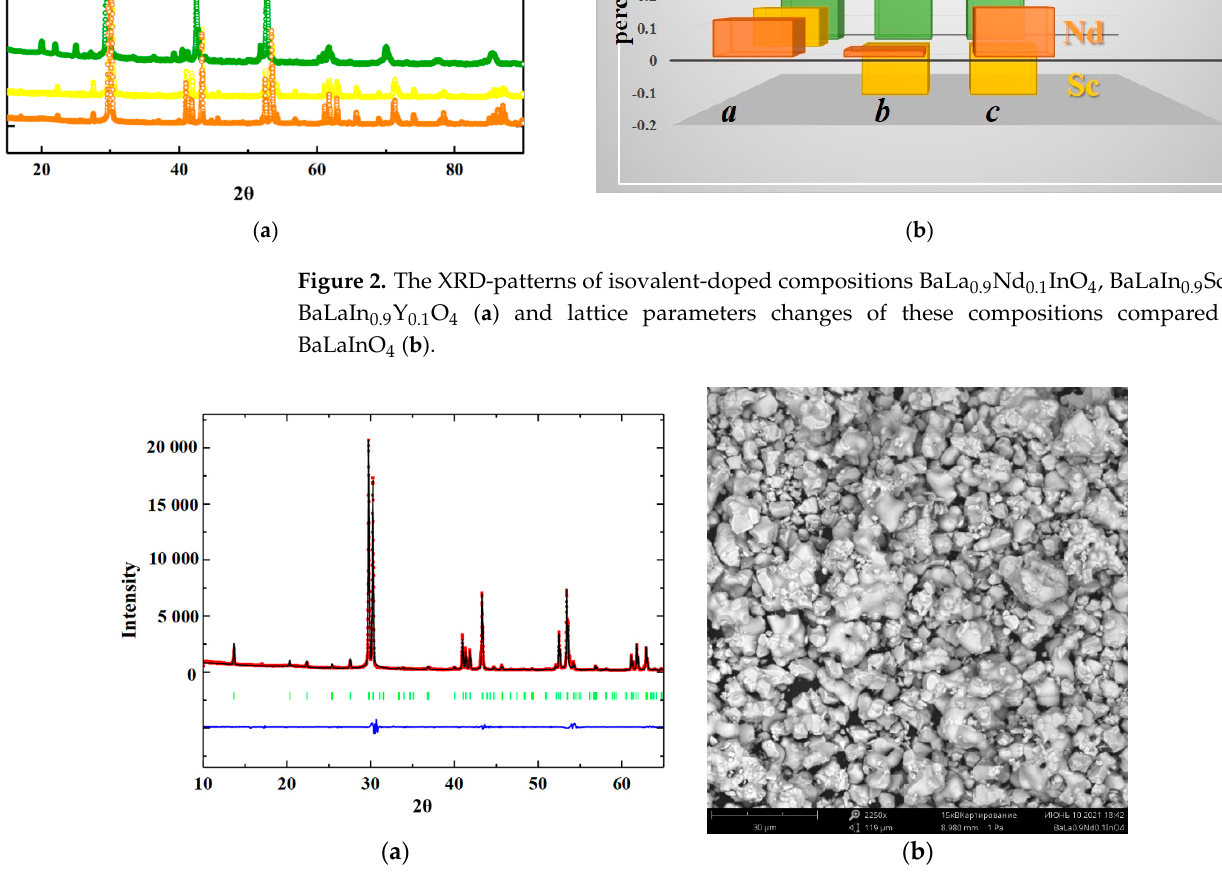
Figure 3. The refinement of XRD-pattern ( a ) and SEM-images of the compositions BaLa 0.9 Nd 0.1 InO 4 ( b ). Table 1. Refined structural parameters from Table 3. The average element ratios determined by EDS analysis for the sample BaLa 0.9 Nd 0.1 InO 4 (theoretical values are in brackets).